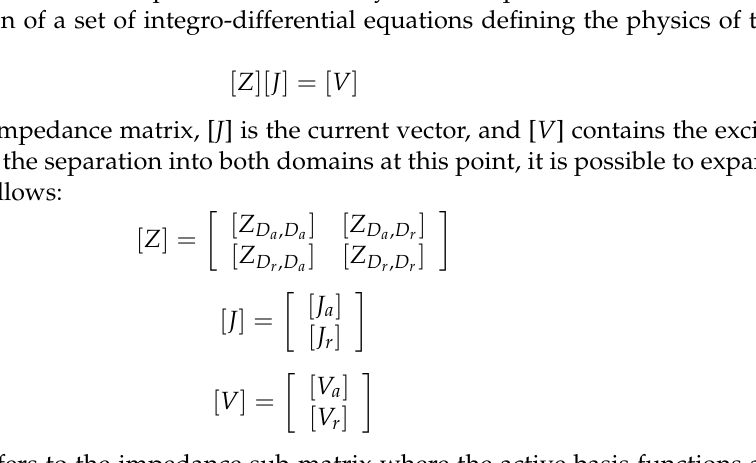
Figure 2. Separation of the antenna and radome domains.